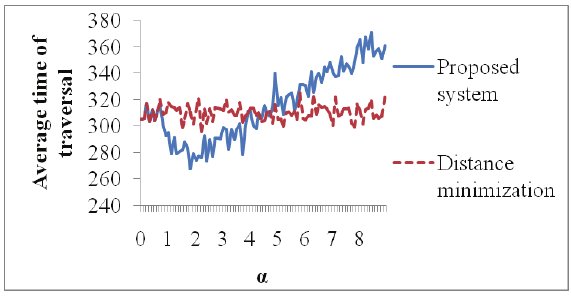
Fig. 6. Comparative analysis of routing system for different values of (cid:302)